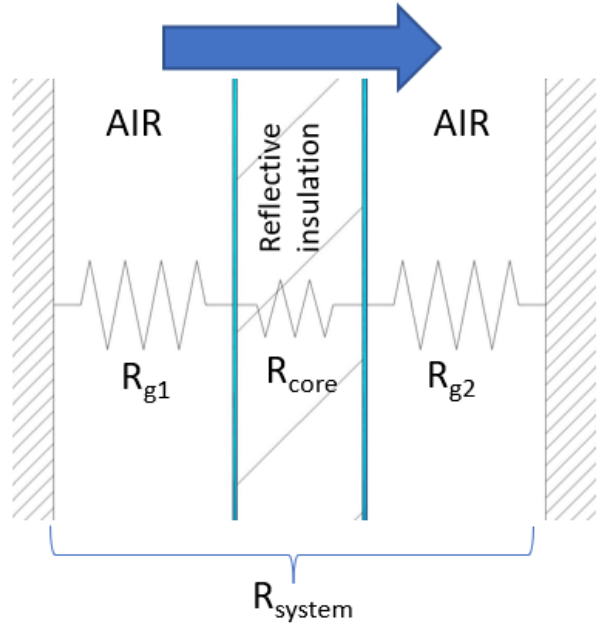
Figure 2. Scheme of the system of thermal resistances considered to compare the calculated results with the declared ones. The resistances associated to the air gaps (R g1 and R g2 ) also consider the reflective contribution. R core represents instead the conductive thermal resistance associated to the core material itself.